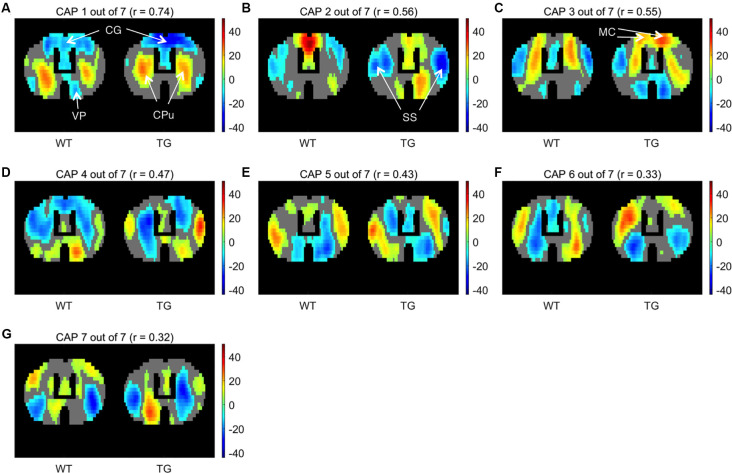
One-sample T-test maps showing significantly (p < 1E-5; Bonferroni corrected) co-activated (T > 0) and co-deactivated (T < 0) voxels for seven WT co-activation patterns (CAPs) and their corresponding matched patterns in the TG. CAPs are ordered in the descending order of spatial similarity between matched CAPs expressed in terms of Pearson’s correlation mentioned in the title of each pattern. CG, Cingulate cortex; CPu, Caudate Putamen; VP, Ventral Pallidum; SS, Somatosensory cortex; MC, Motor cortex.